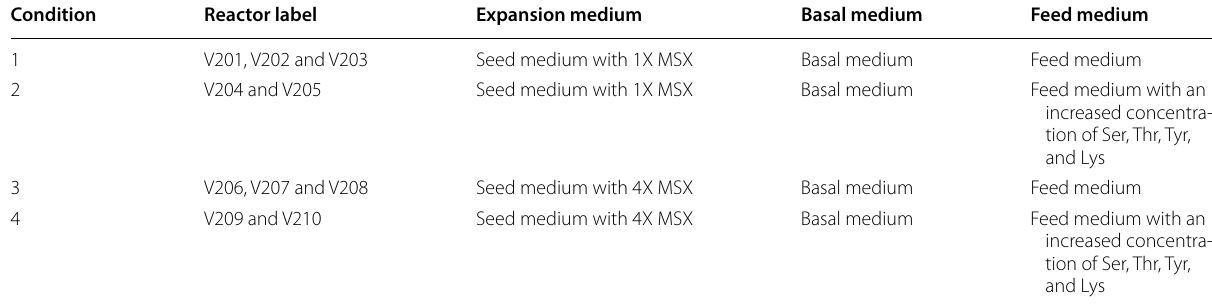
Table 1 Initial experimental conditions Condition